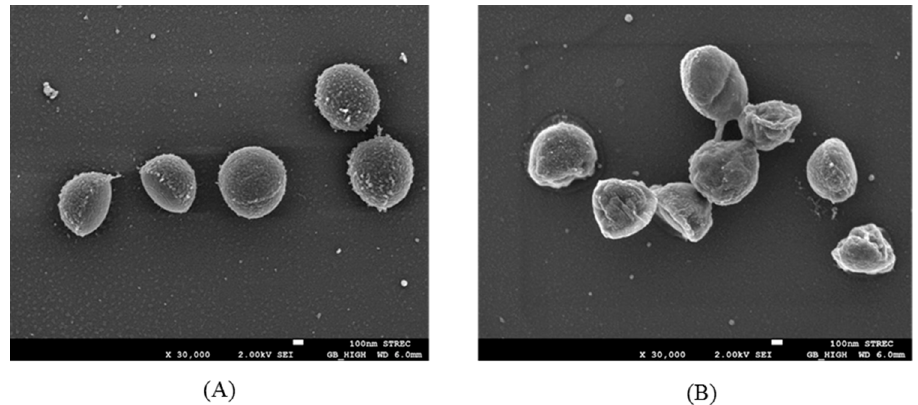
Figure 5. Scanning electron micrographs of S. aureus after incubation at 37 °C for 8 h; ( A ) Viable cells (30,000 × ) in NSS without lactic acid; ( B ) Non-viable cells (30,000 × ) with 5% v / v lactic acid.